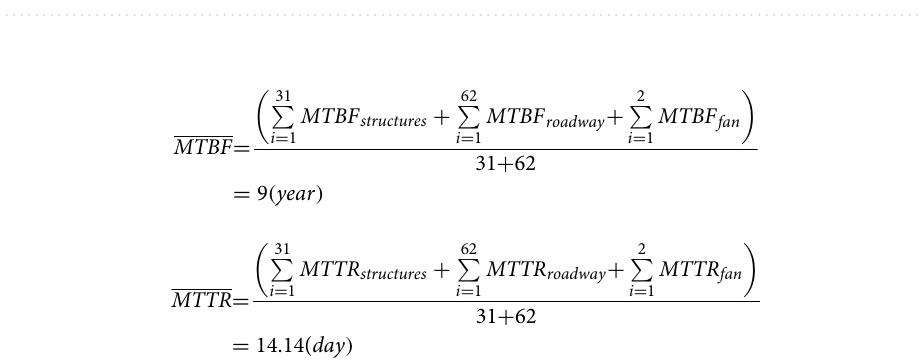
Table 3. State transition